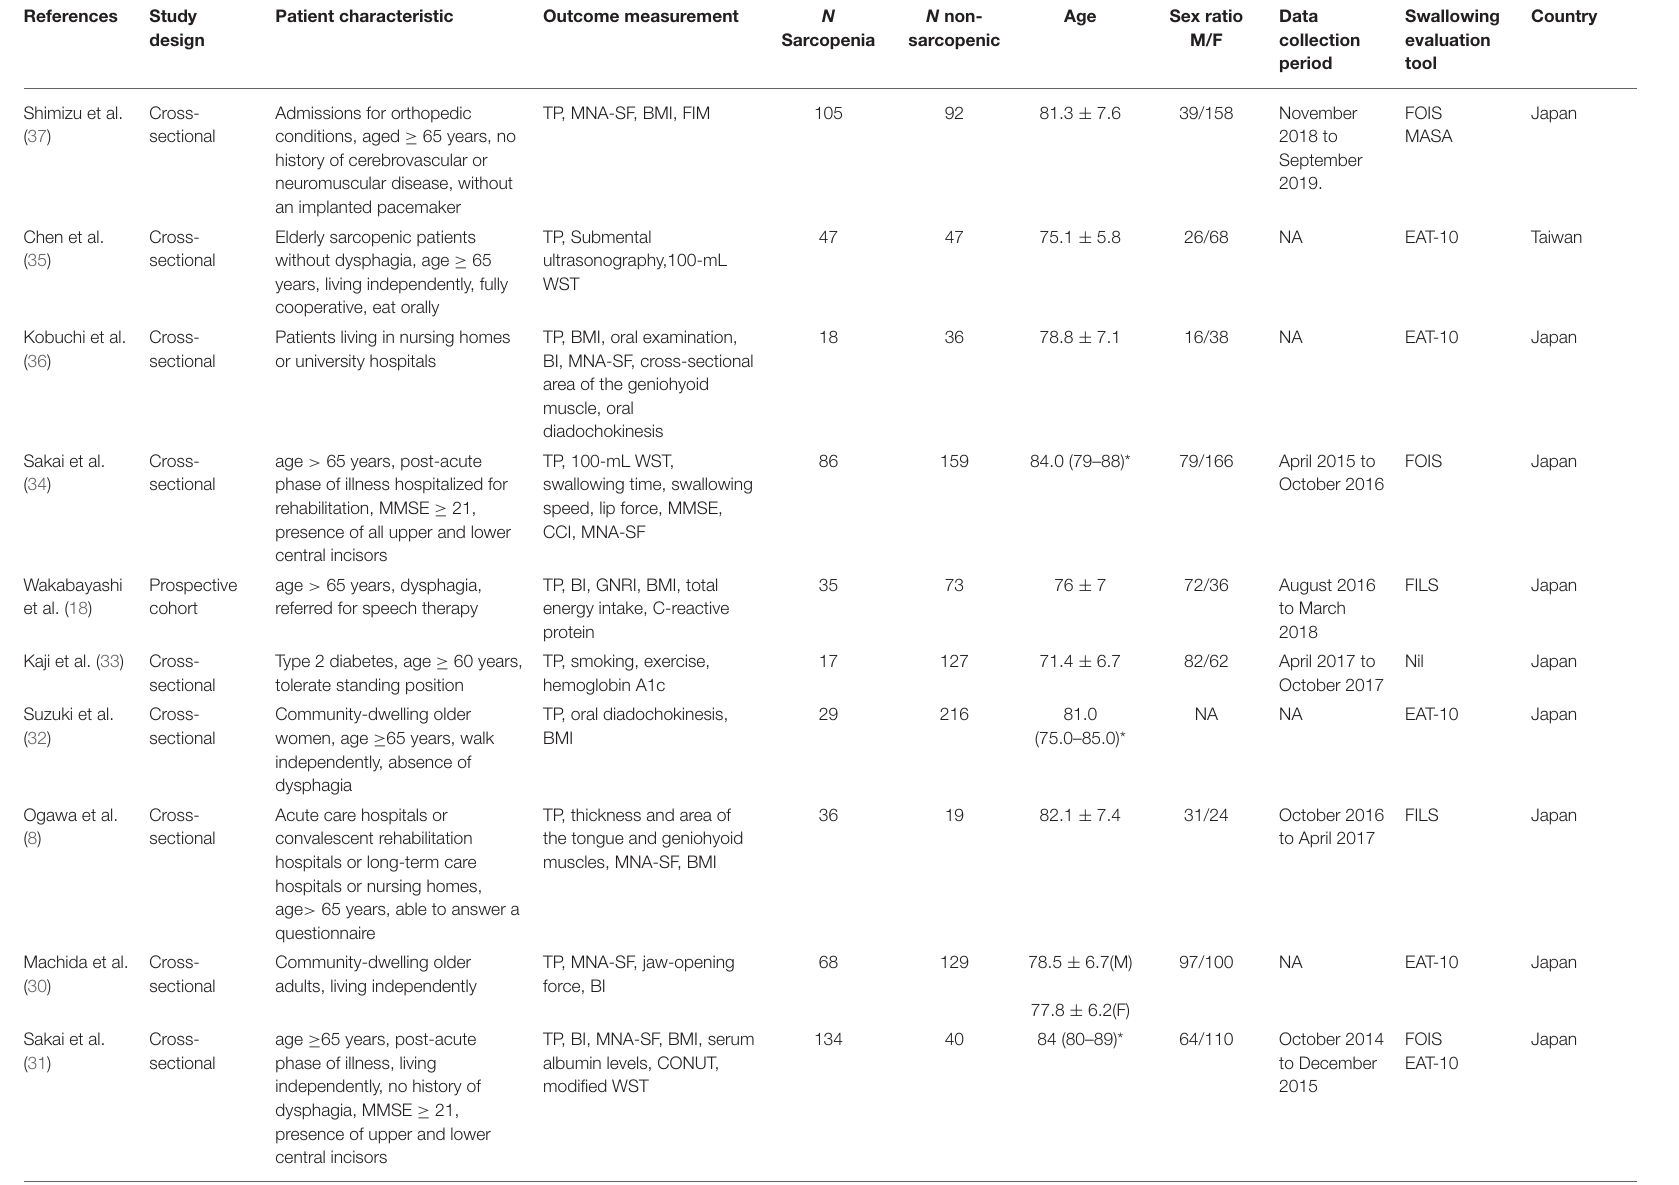
TABLE 1 | Characteristics of the included